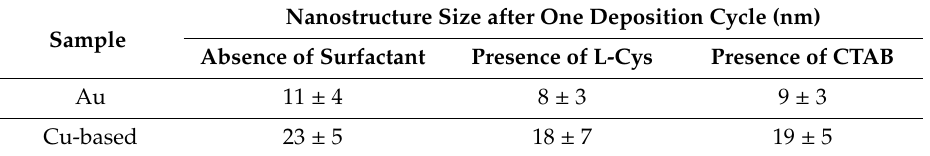
Table 1. Average nanostructure size of Au and Cu-based samples.